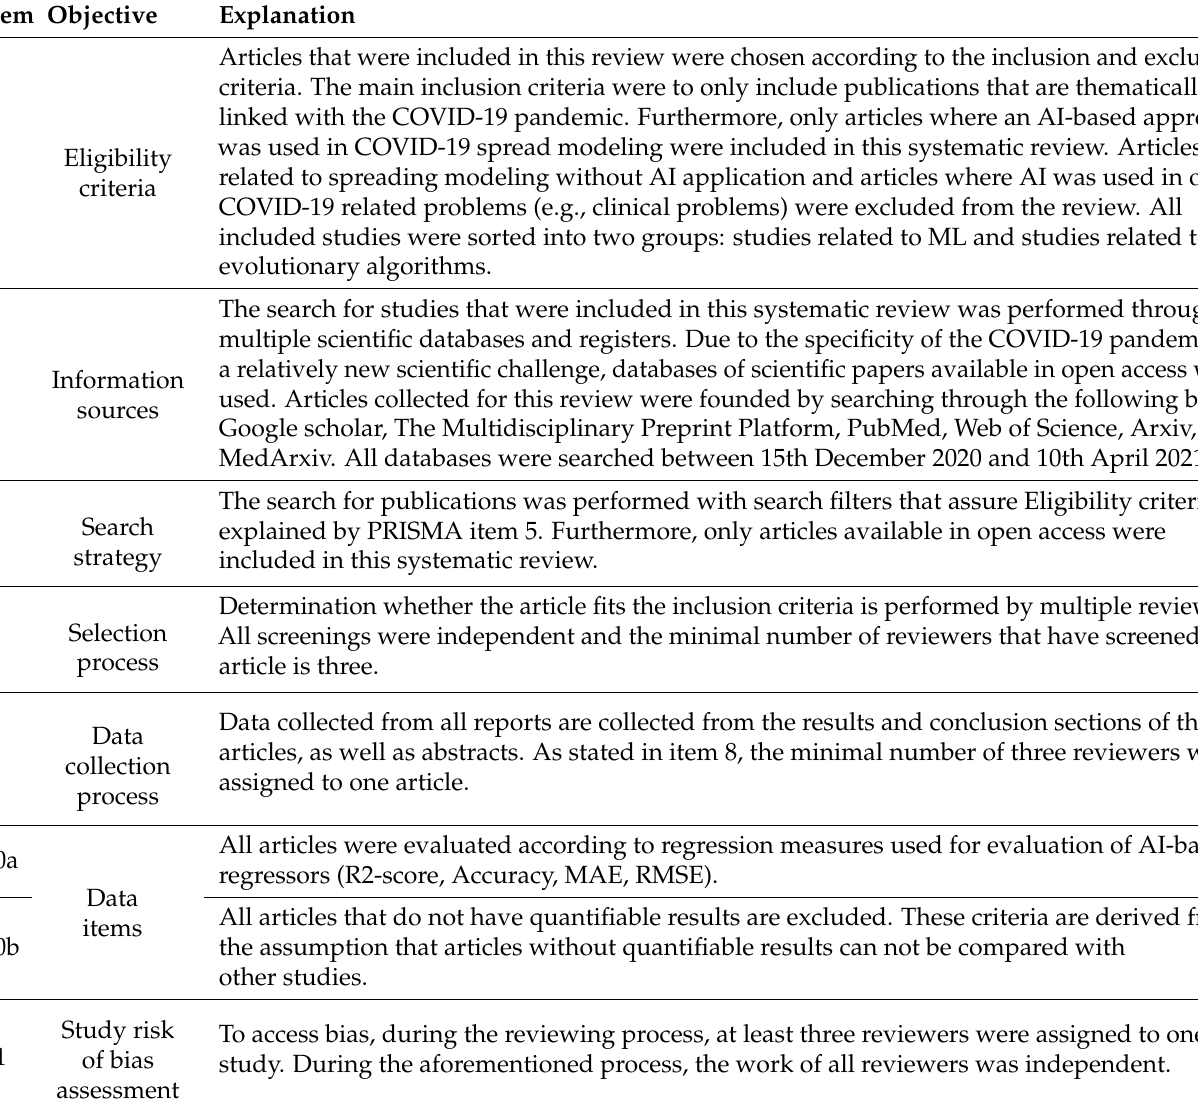
Table 1. Review methodology with explanations, according to PRISMA 2020